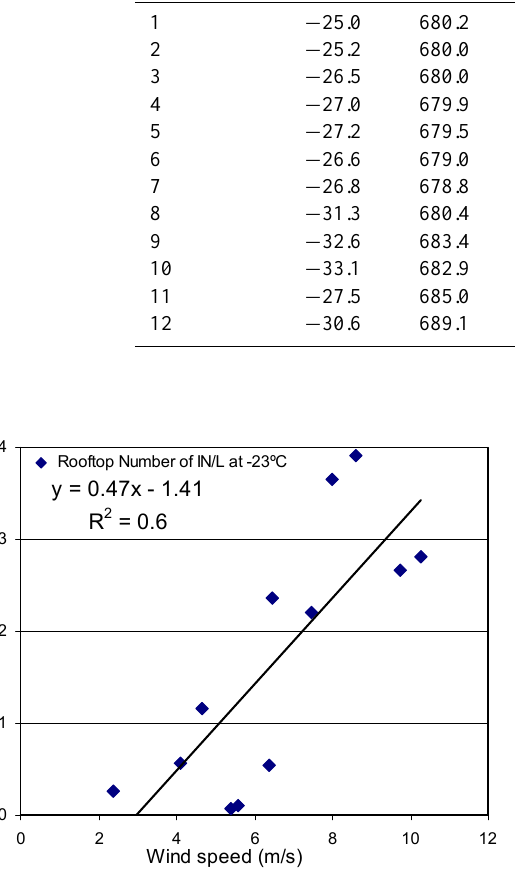
Fig. 7b: Concentration of aerosols > 0.01 μ m as a function of wind speed. Fig. 7b. Concentration of aerosols > 0 . 01µm as a function of wind